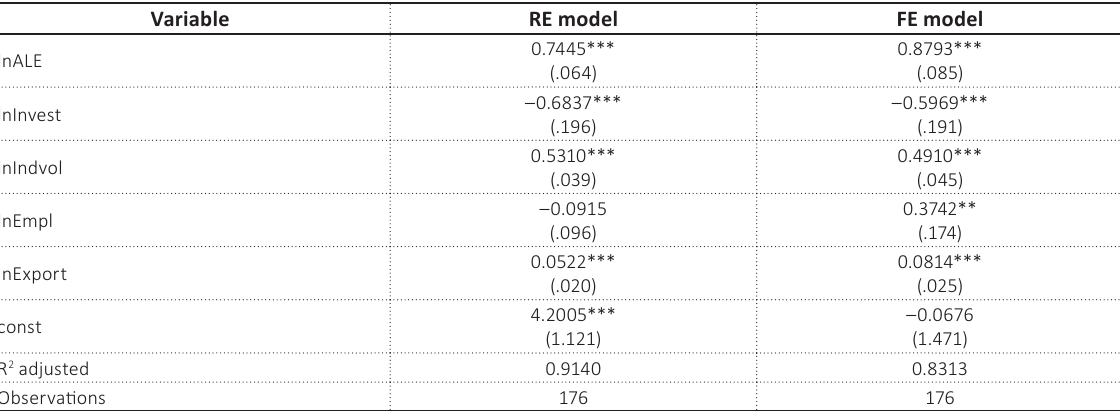
Table 3. Regression model of Kazakhstani regions for